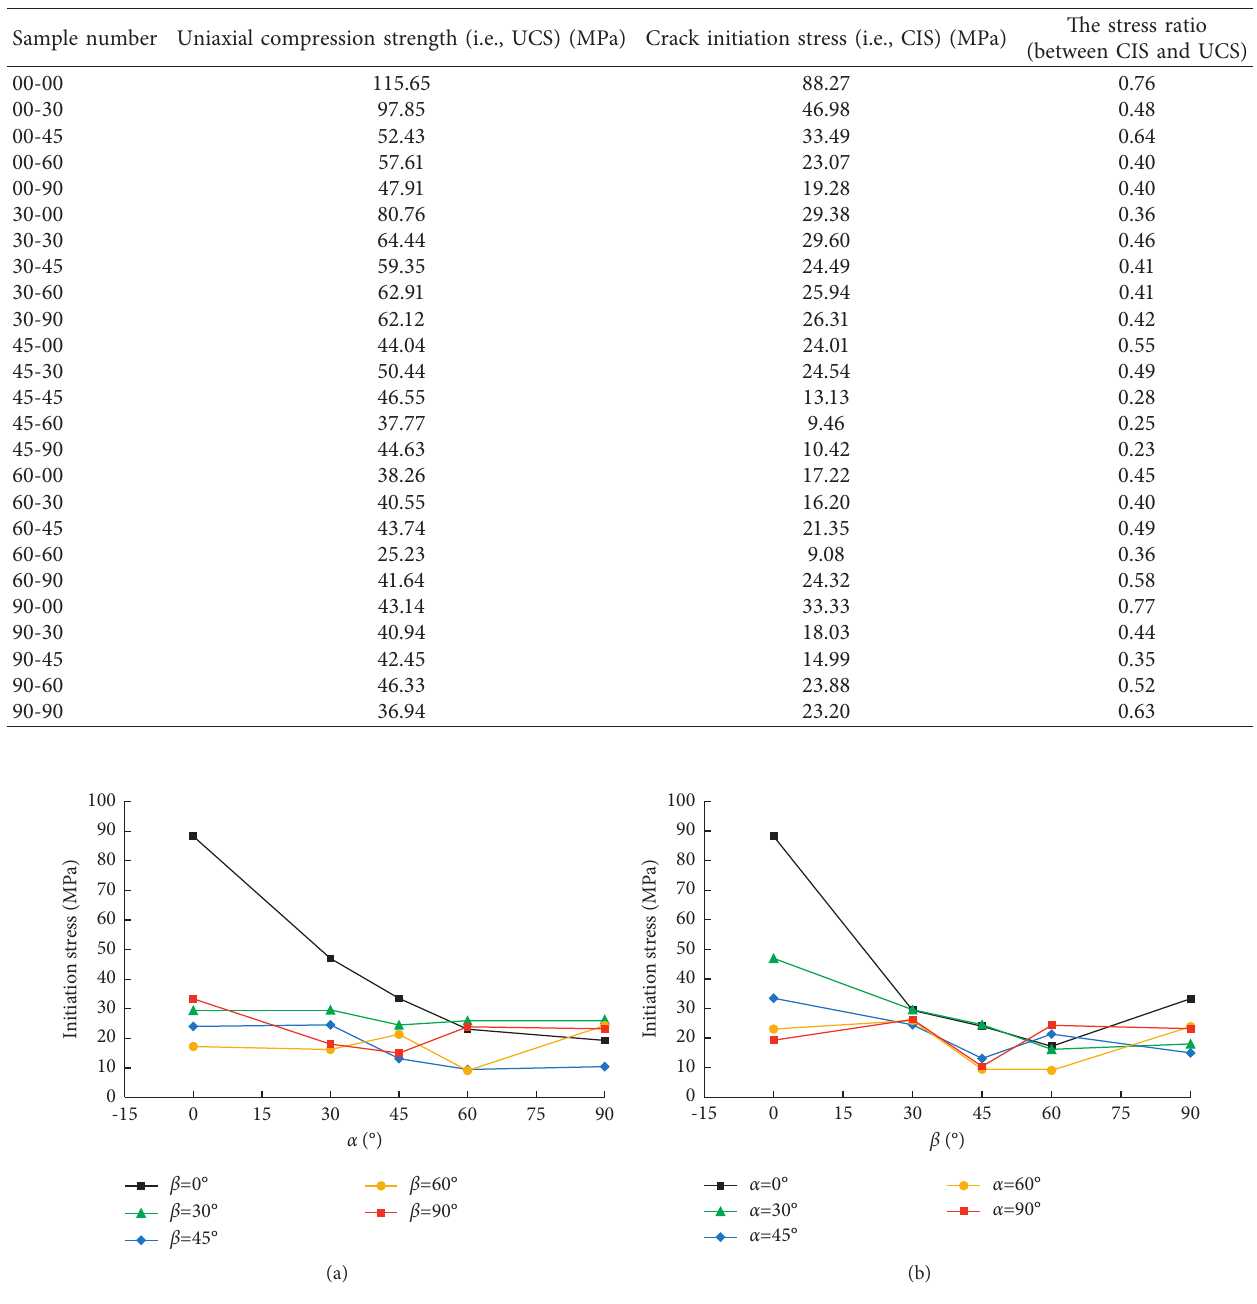
Table 1: UCS and CIS of the samples with different crack angles.